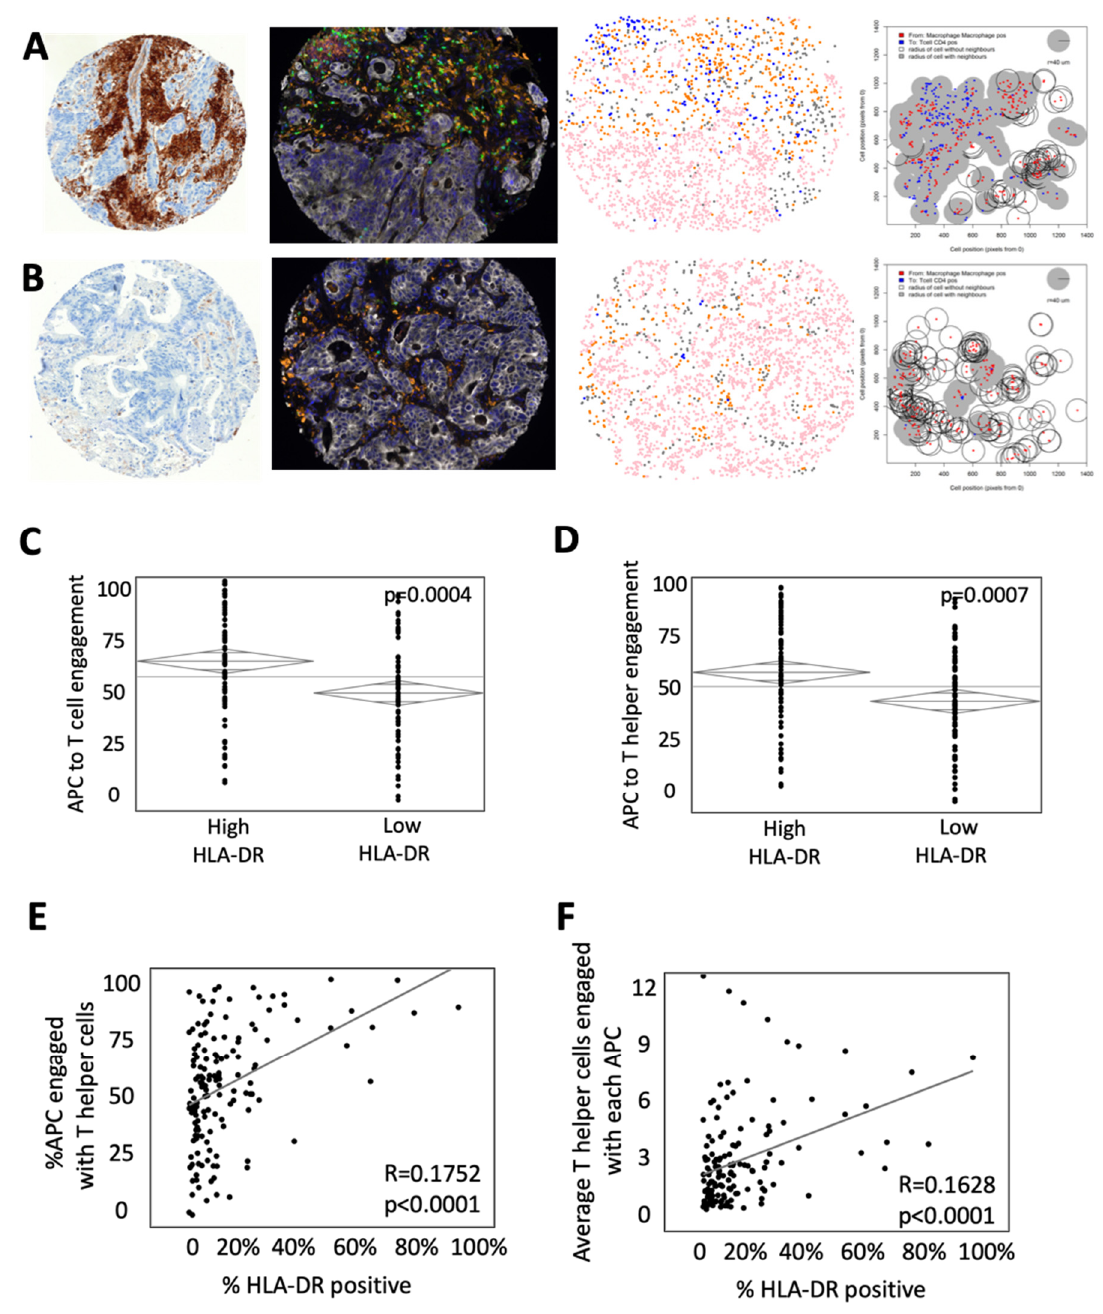
Figure 2. High HLA-DR expression is associated with increased engagement of T cells and antigen present cells (APCs). ( A ) Representative example of a tumor with high HLA-DR expression (Left to right: (a) immunohistochemistry for HLA-DR, (b) composite multiplex immunohistochemistry image stained for CD3—green, CD163—orange, CD8—yellow, pancytokeratin—white, FoxP3—red, PD-L1—magenta and DAPI—blue, (c) phenotypic map depicting the location of CD3 + T cells (blue), pancytokeratin-positive epithelial cells (pink), CD163 + antigen-presenting cells (orange) and other cells (gray), (d) cell engagement analysis between antigen-presenting cells (red) and T helper cells (blue) with the shaded area representing engaged cells.) ( B ) Representative example of a tumor with low HLA-DR expression with images as described above. ANOVA analysis of the percent of APCs engaged with ( C ) T cells and ( D ) T helper cells. Bivariate comparison of the percentage of HLA-DR positivity by surface area and engagement with ( E ) T cells and ( F ) T helper cells.